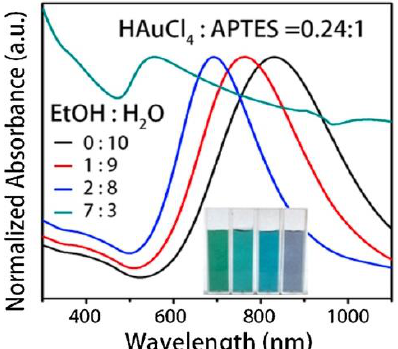
Figure 16. UV-Vis absorption spectra investigation of gold nanoshells synthesized through different ratios of ethanol/water mixture. Reprinted with permission from Reference [85]. Copyright (2016)